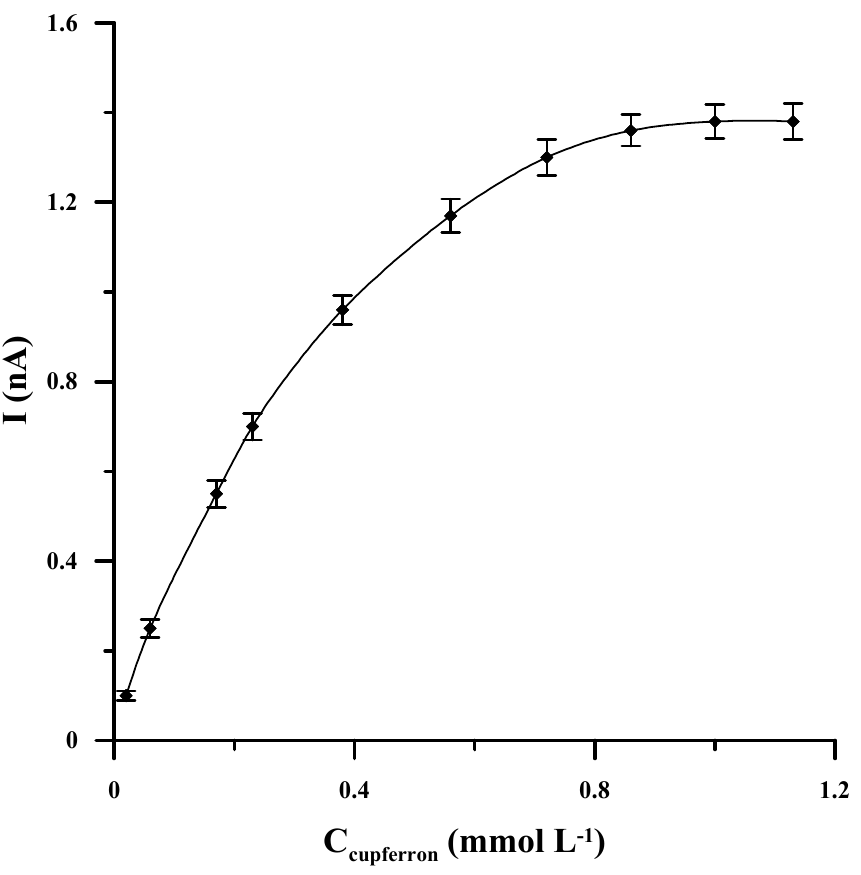
Figure 2. The effect of cupferron concentration on the AdSV voltammetric response of 1 × 10 -8 mol L -1 V(V). The accumulation potential and time were -0.4 V and 60 s, respectively.